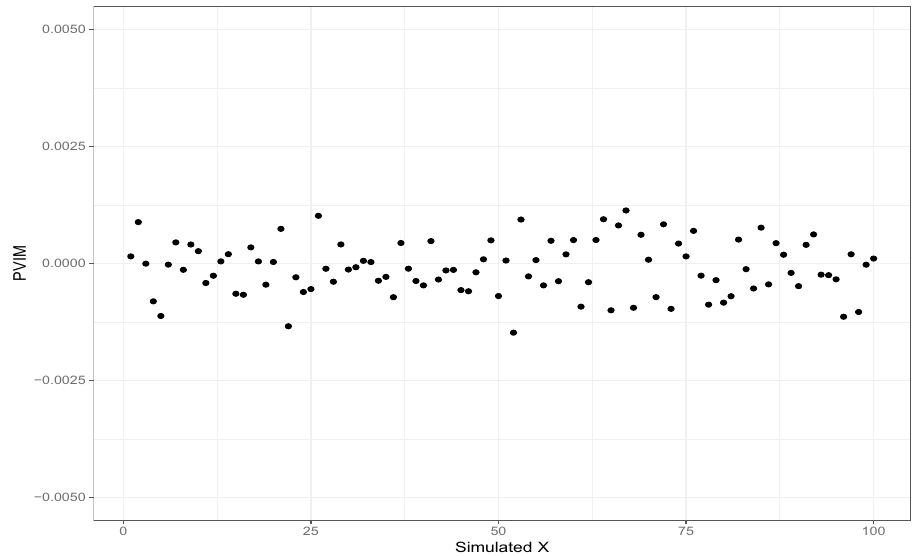
Figure 3. Average prediction variable importance scores across 100 replications for all of the predictors output from the FunFor approach in Simulation 5.